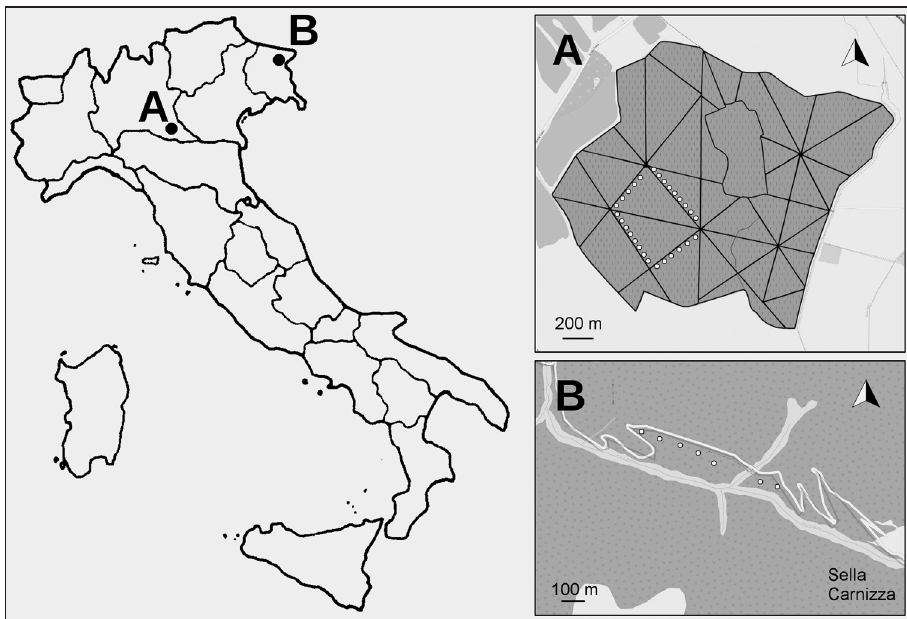
Figure 1. The two study areas, located in Bosco della Fontana ( A ) and in the Parco Naturale Regionale delle Prealpi Giulie ( B ) (northern Italy). White dots in A represent single log piles, white dots in B rep- resent blocks of three log